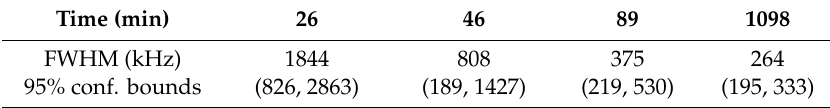
Table 3. Time evolution of FWHM data (kHz) of sample